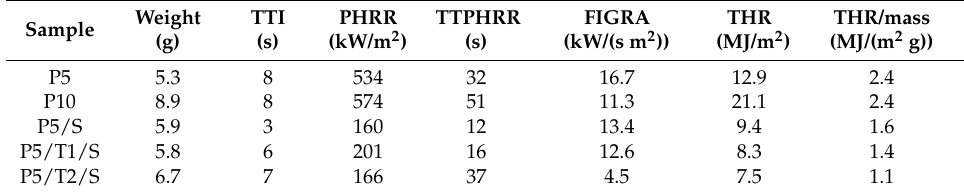
Table 4. Cone calorimeter data of PVA, PVA/NaOH, PVA/TA/NaOH